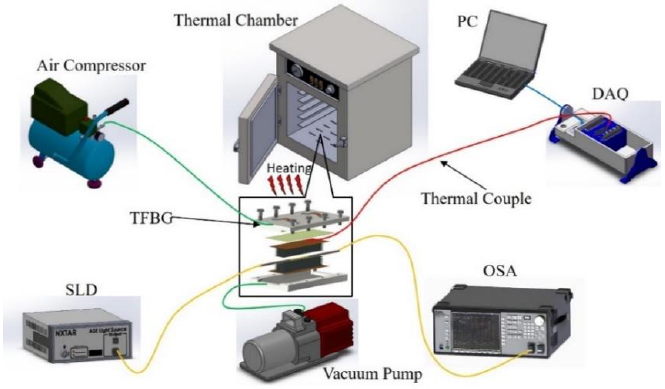
Figure 5. Diagram of experimental system for CFRP composite material curing monitoring with TFBG sensor.